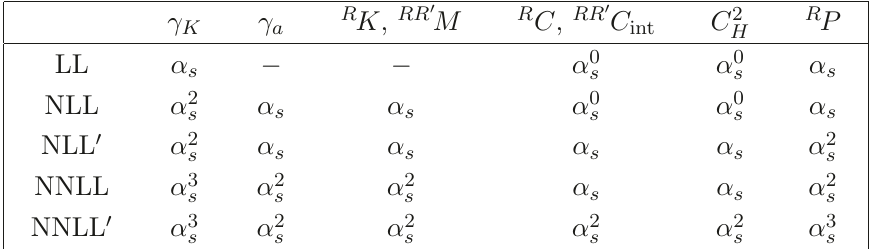
Table 3. Different levels of accuracy and the associated orders of α s for the perturbative ingredients in the SPS cross section. The order required for the β function is the same as for γ K